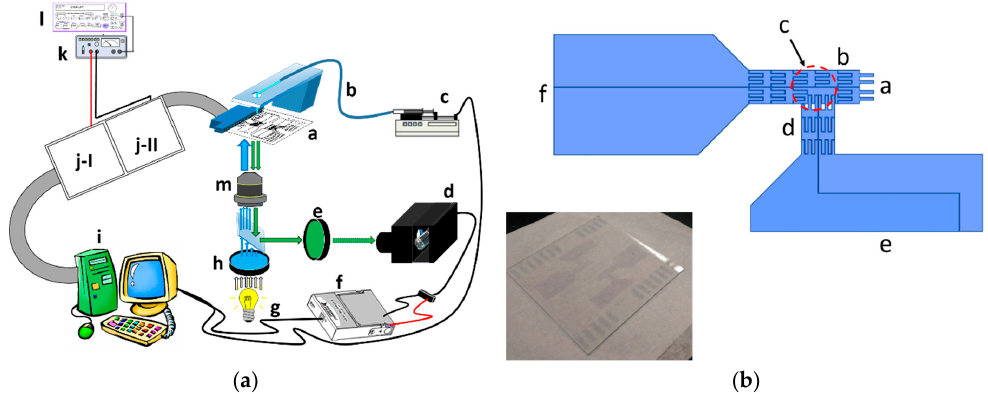
Figure 1. ( a ) the schematic illustration of coplanar electro-wetting based microfluidic sorter. a. electro-wetting-on-dielectrics (EWOD) chip; b. sample delivery capillary; c. syringe pump; d. photomultiplier tube; e. bandpass filter (532 nm); f. digital input/ output interface card (NI 9215 DAQ); g. mercury lamp; h. bandpass filter (488 nm); i. personal computer with digital input/ output